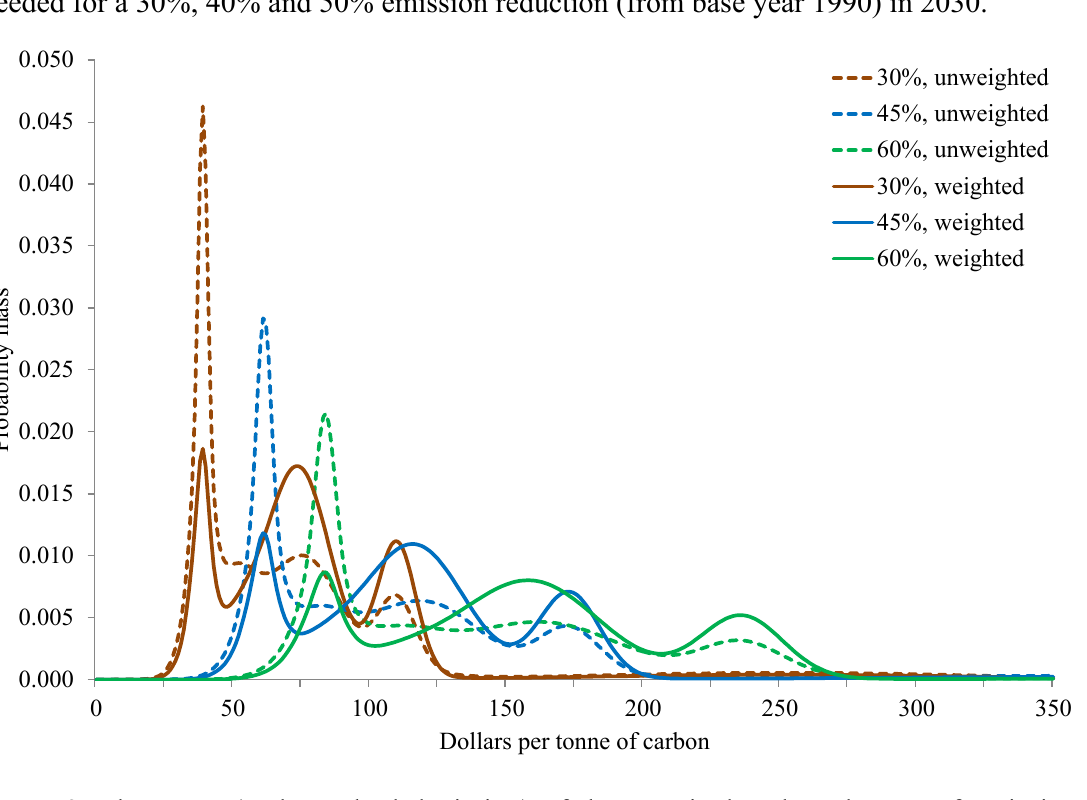
Table 2. The mean (and standard deviation) of the marginal and total costs of emission reduction in 2030 for three alternative targets and two alternative pdfs; also shown are the risk and ambiguity premiums on the total costs and the differences between results for the alternative